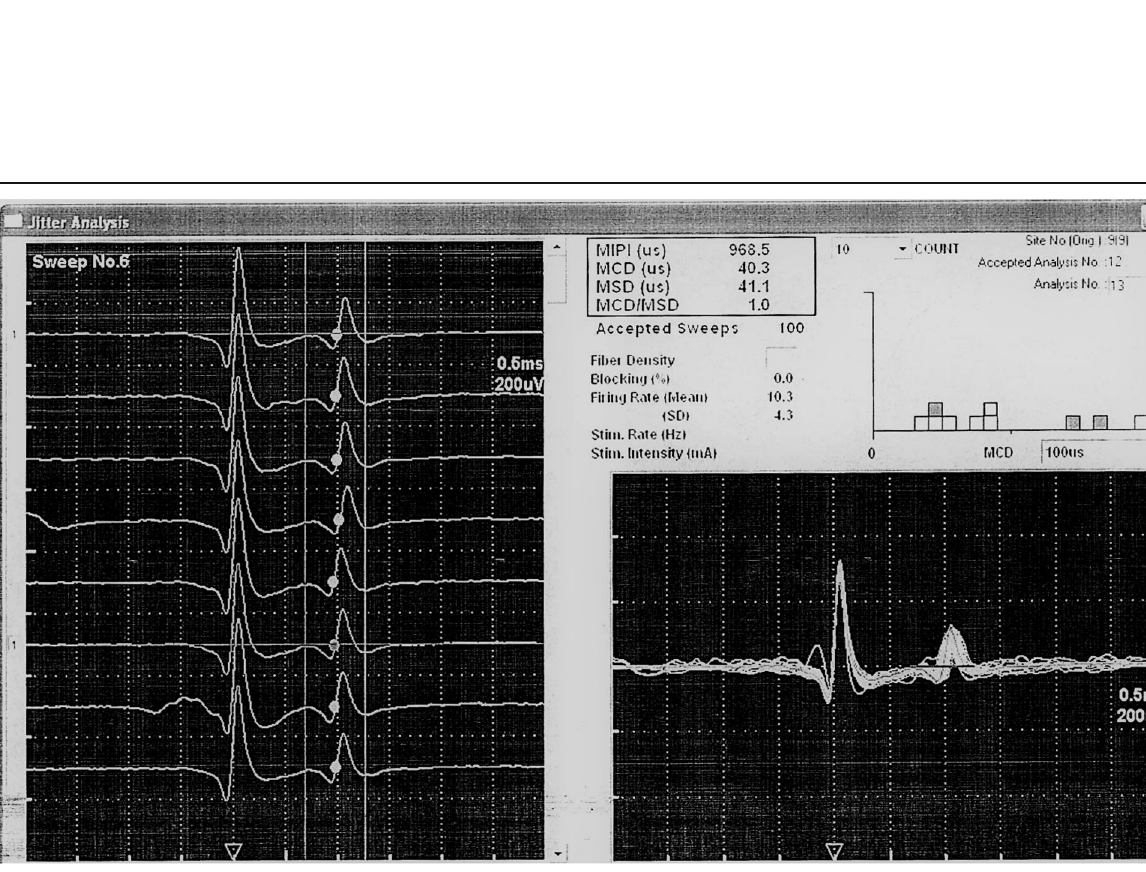
Fig. 2 SFEMG potentials recorded from APB during voluntary contraction. Trace obtained from a CTS patient. MCD is = 40.3 μ